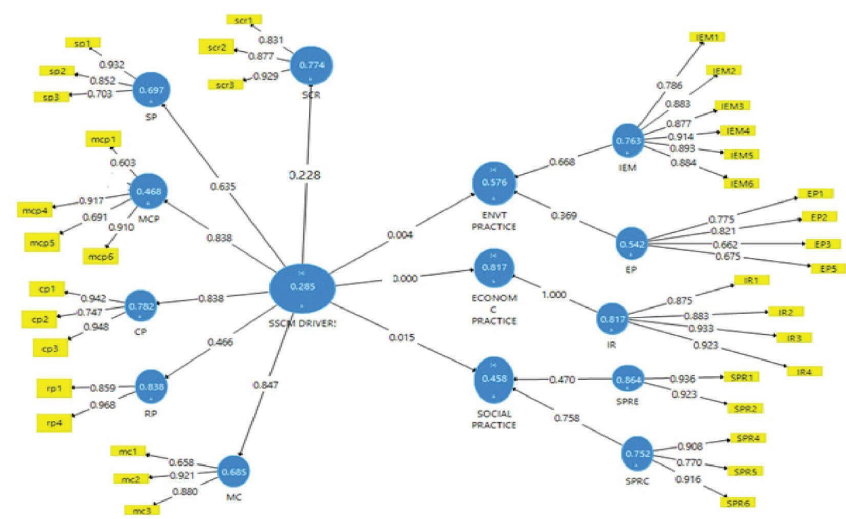
Figure 5: Restructured structural